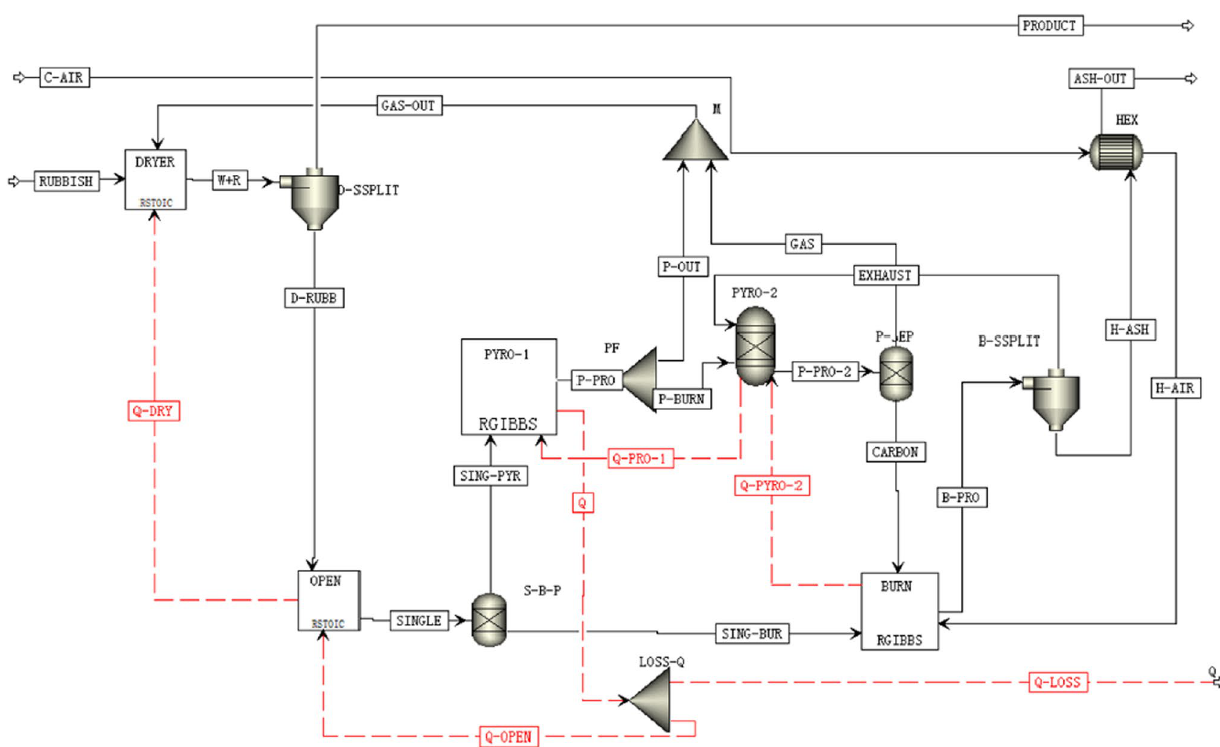
Fig. 2 Hybrid pyrolysis model of the counter-flow rotary kiln incineration